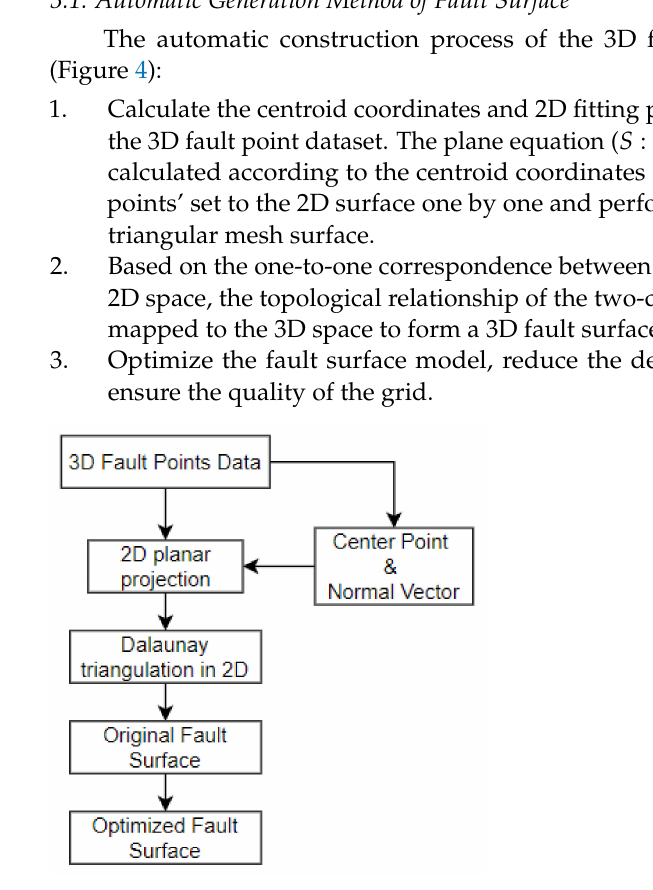
Figure 4. Automatic generation process of 3D fault surface.